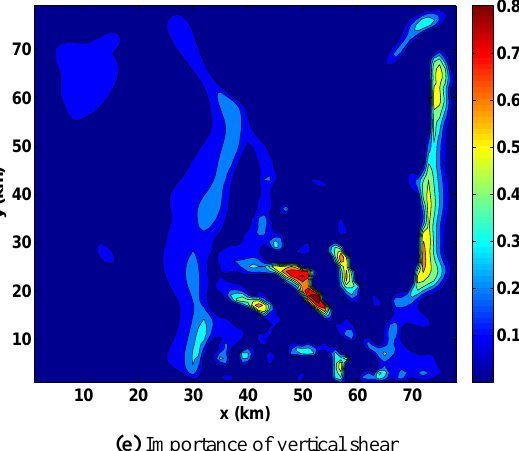
Fig. 5. Region in which InSAR-derived velocities were inverted for basal traction. (a) Region in which InSAR-derived velocities were inverted for basal traction. (b) Convergence of inverse model. Both complete and incomplete adjoints converge, but inclusion of nonlinear terms gives marginal improvement. (c) InSAR-derived speed (filled contours) and AGASEA bed elevation (labeled contours). (d) Inversion results for the complete and incomplete adjoints, with an initial guess for β of 10Pa shear, i.e. the speed due to vertical shear divided by the surface speed for the inverted